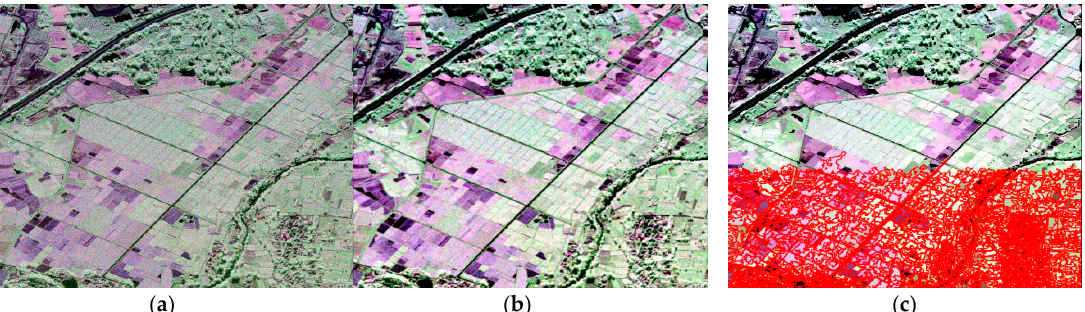
Figure 9. The Pauli-RGB imagery of UAVSAR after speckle filtering and GSRM segmentation: ( a ) The Pauli-RGB imagery of original UAVSAR imagery; ( b ) The Pauli-RGB imagery of UAVSAR after speckle filtering; ( c ) The Pauli-RGB imagery of UAVSAR after GSRM segmentation.